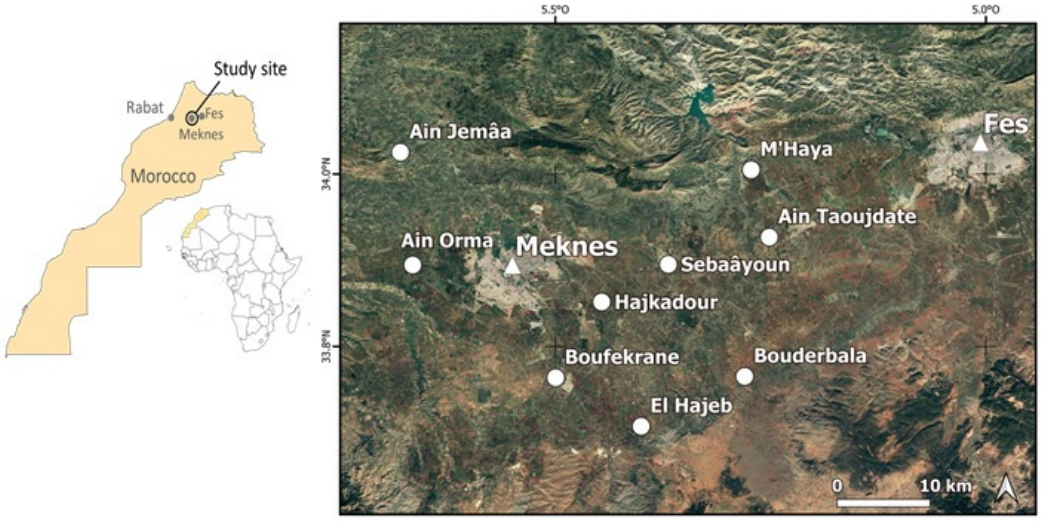
Figure 1. Location of the nine sites (white circles) surveyed during the 2017 / 2018 and 2018 / 2019 cropping seasons in Morocco.